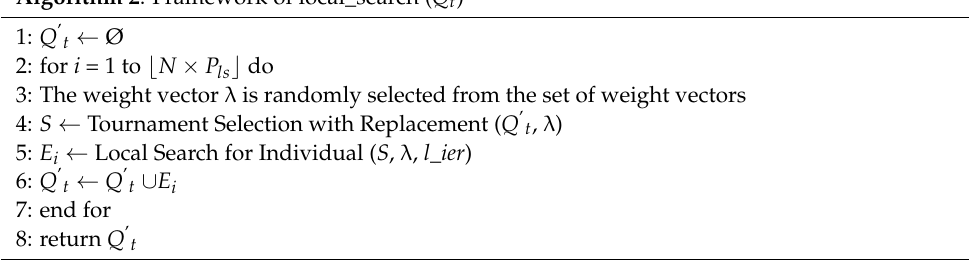
Algorithm 2 . Framework of local_search ( Q t